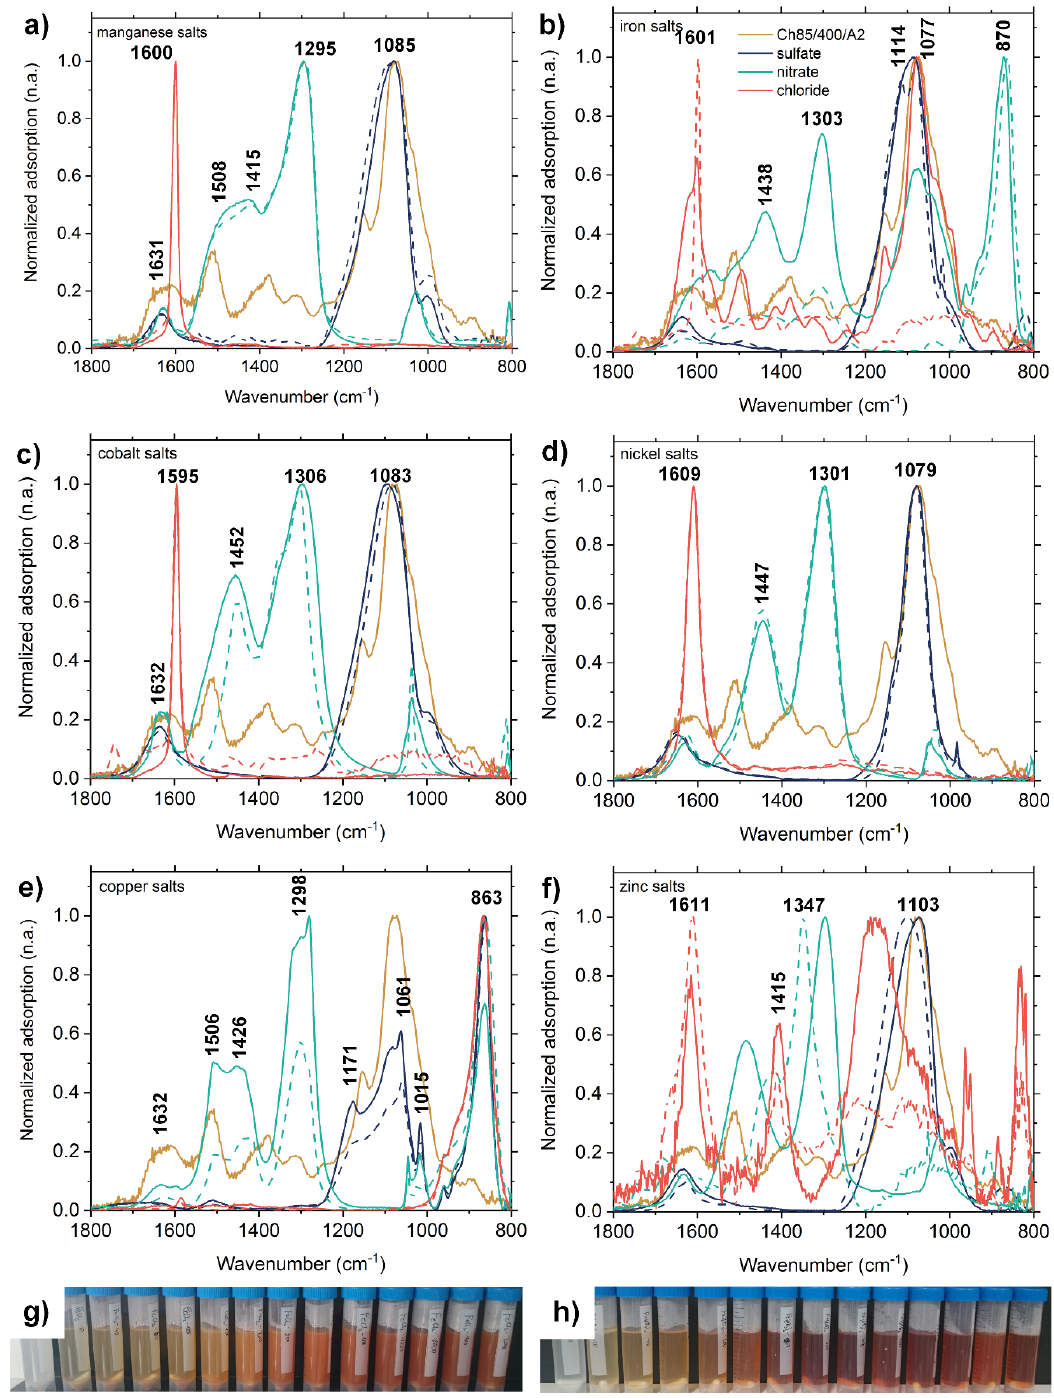
Figure 2. ( a )–( f ) show the FTIR spectra of the metal salt solutions before (dashed line) and from the supernatant after (full line) the adsorption. For comparison, the yellow spectrum shows the pure chitosan. ( a ) MnSO 4 (blue), Mn(NO 3 ) 2 (red), and MnCl 2 (green); ( b ) FeSO 4 (blue), Fe(NO 3 ) 3 (red), and FeCl 2 (green); ( c ) CoSO 4 (blue), Co(NO 3 ) 2 (red), and CoCl 2 (green); ( d ) NiSO 4 (blue), Ni(NO 3 ) 2 (red), and NiCl 2 (green); ( e ) CuSO 4 (blue), Cu(NO 3 ) 2 (red), and CuCl 2 (green); ( f ) ZnSO 4 (blue), Zn(NO 3 ) 2 (red), and ZnCl 2 (green), ( g ) adsorption experiments chitosan with FeCl 2 , and ( h ) adsorption experiments of chitosan with Fe(NO 3 ) 3 . The concentration of salt solutions was 2 g · L − 1 in relation to the metal